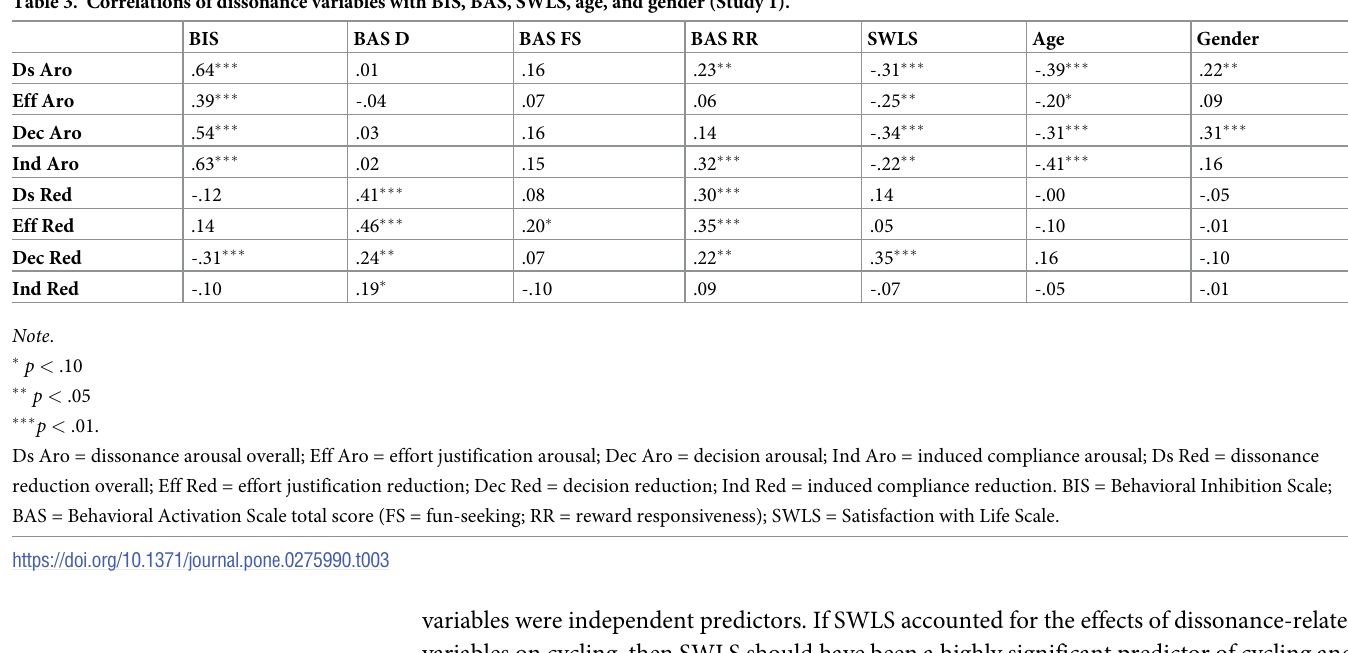
Table 3. Correlations of dissonance variables with BIS, BAS, SWLS, age, and gender (Study 1). BIS BAS D BAS FS